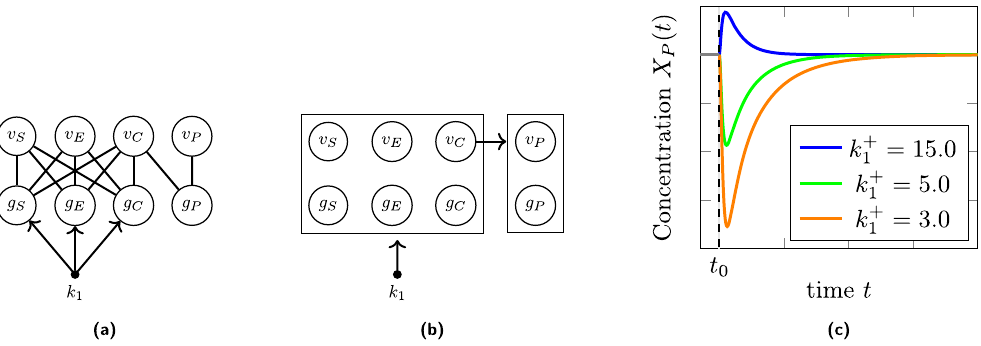
Figure A1: The dynamic bipartite graph ( a ) and dynamic causal ordering graph ( b ) for the basic enzyme reaction modelled by equations ( A1 ) – ( A4 ) . Panel ( c ) shows simulations that suggest that the concentration X P perfectly adapts after an initial transient response to a persistent change in the parameter k 1